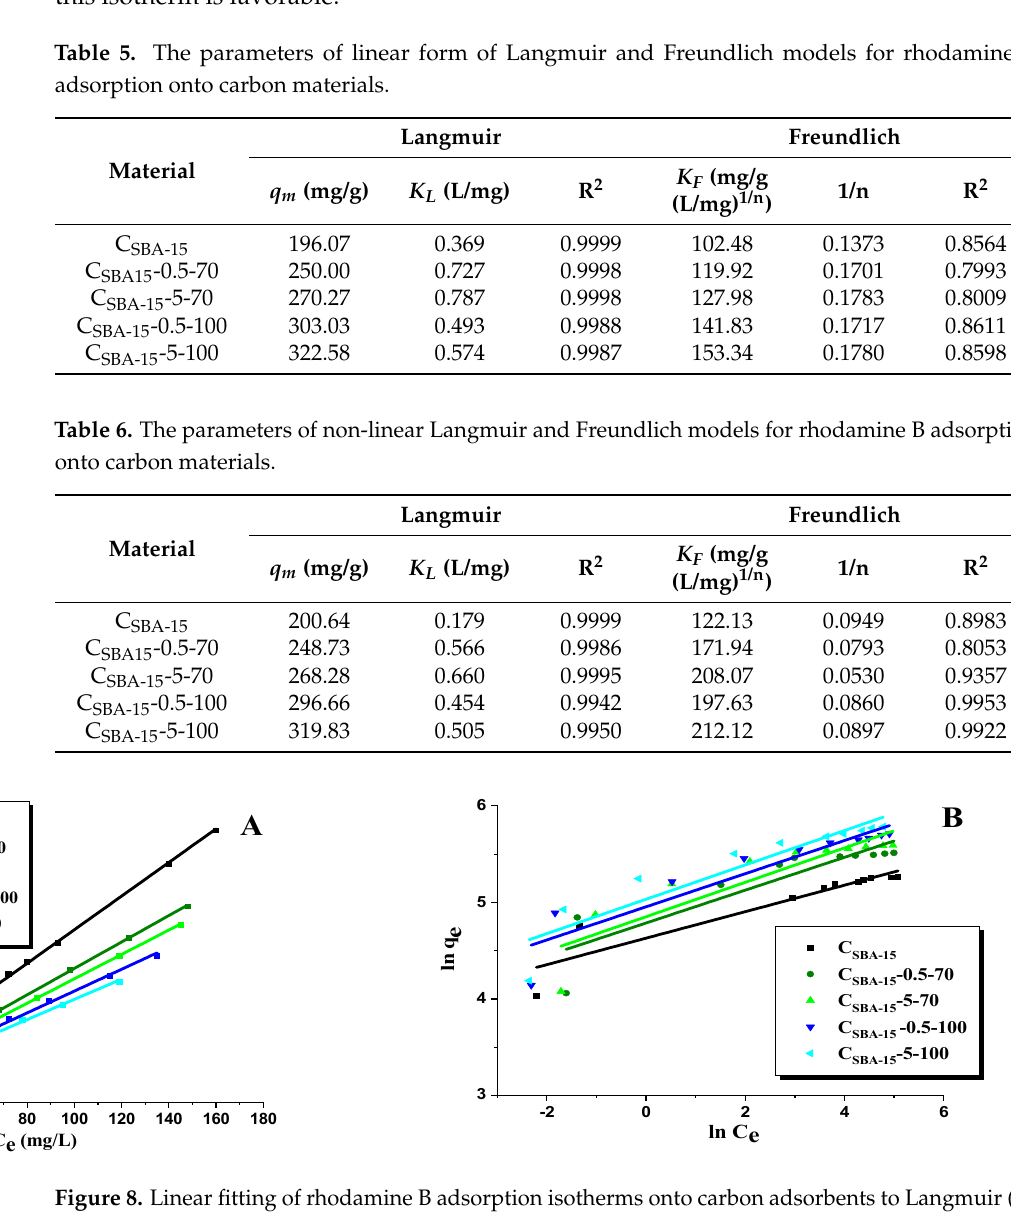
Figure 8. Linear fitting of rhodamine B adsorption isotherms onto carbon adsorbents to Langmuir ( A ) and Freundlich ( B ) models.